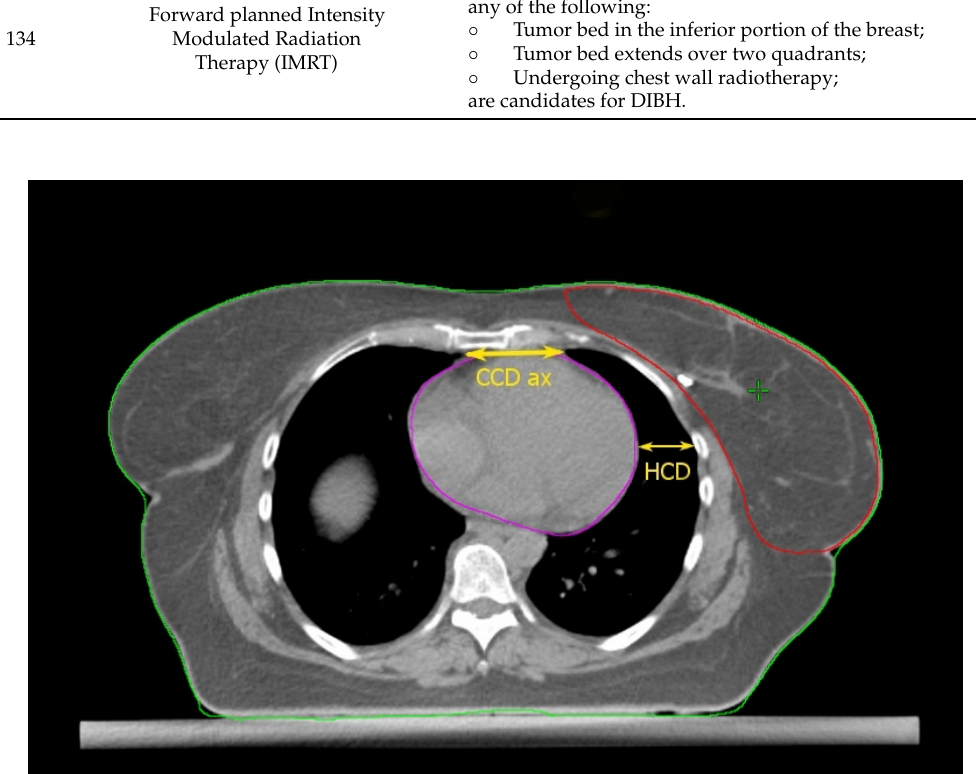
Figure 1. Anatomical parameters on the axial CT plane passing through the liver dome. Read the text for the explanation.